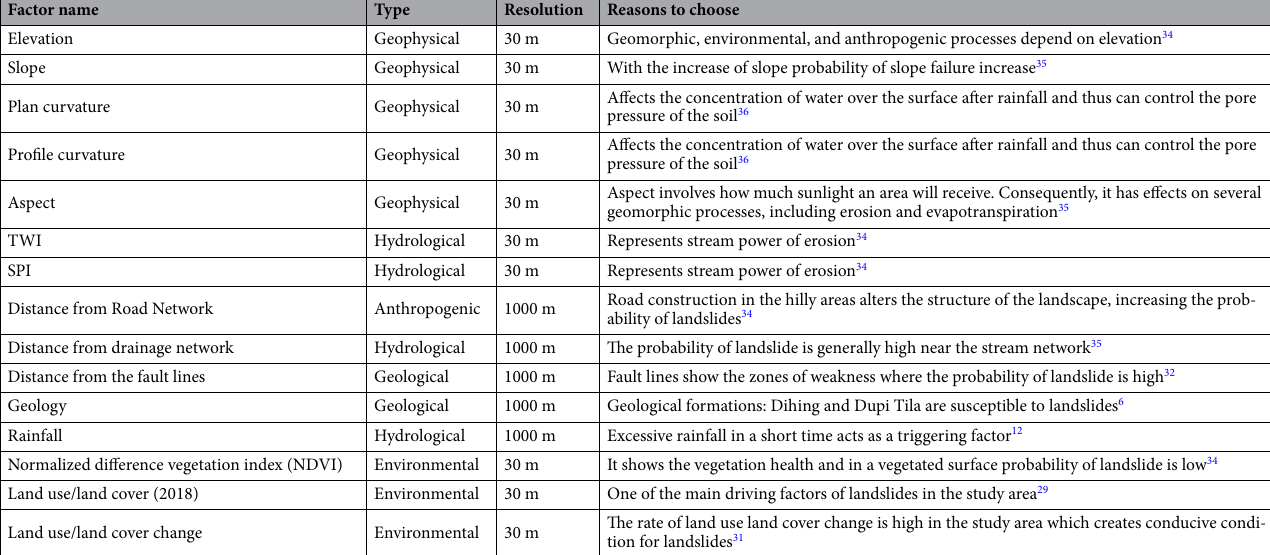
Table 1. Landslide causal factors used in this